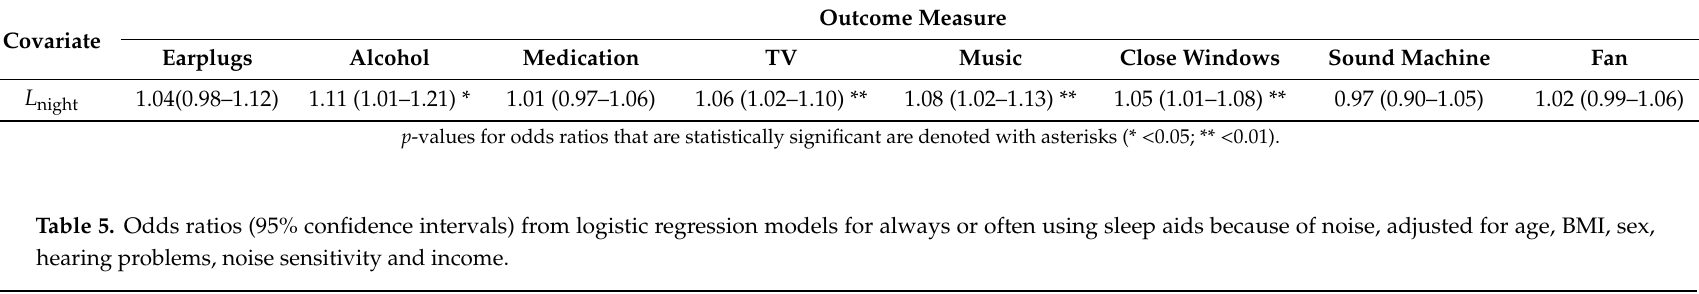
Table 4. Odds ratios and 95% confidence intervals from unadjusted logistic regression models for always or often using sleep aids because of noise. Outcome Measure Covariate Earplugs Alcohol Medication TV Music Close Windows Sound Machine Fan